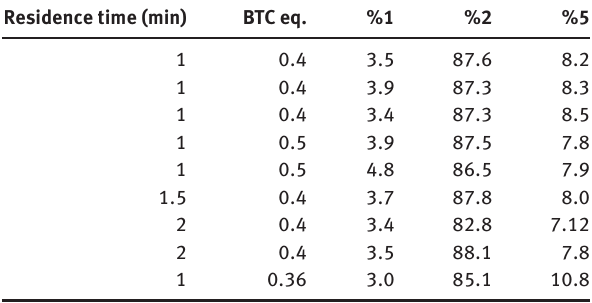
Figure 6 Schematic view of fed-batch system.